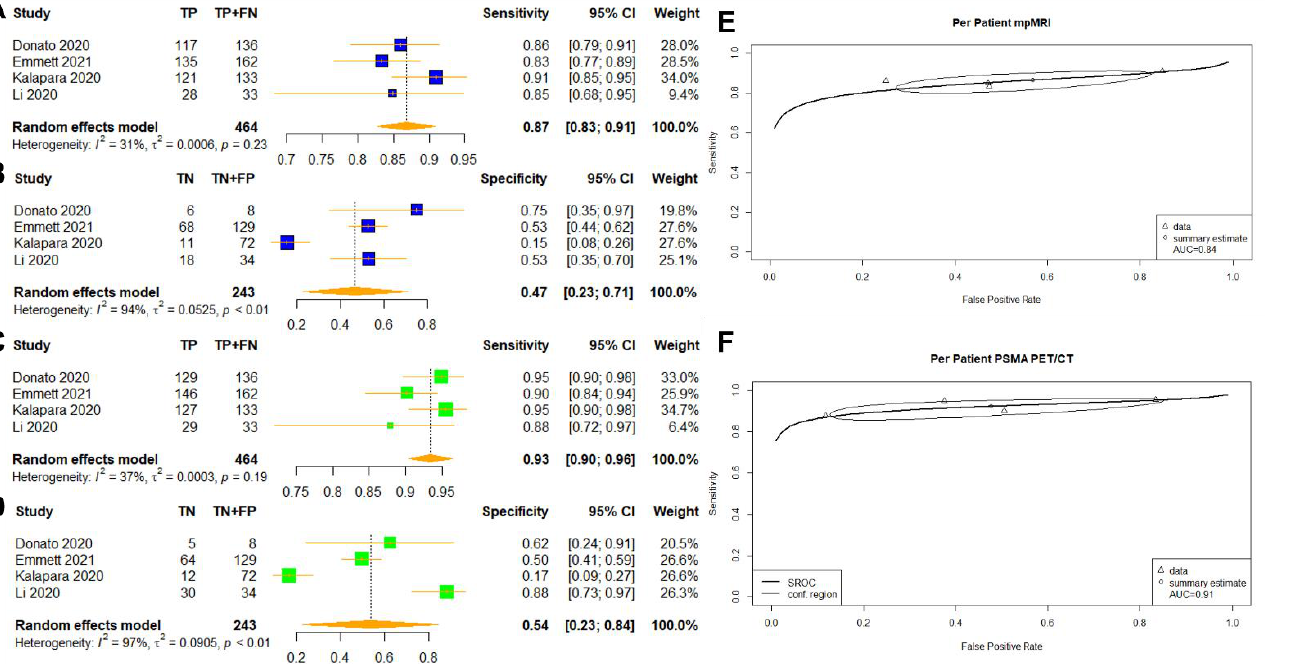
Figure 2. ( A – F ) Reported sensitivity and specificity values for both mpMRI and PSMA PET/CT with AUC values on SROC curves for per-patient analysis. Forest plots for pooled sensitivities and specificities are displayed in bold and as diamonds in the graphs for mpMRI ( A , B ) and PSMA PET/CT ( C , D ). The SROC curves indicate the summary estimates in circles ( E for mpMRI; F , PSMA PET/CT). Triangles represent included study, with dotted lines representing the confidence interval and solid lines for the SROCs. AUC values are displayed in the legend. mpMRI = multiparametric magnetic-resonance imaging; PSMA PET/CT — prostate-specific membrane antigen positron-emission tomography/computed tomography; AUC — area under the curve, SROC — summary receiver operating characteristic.